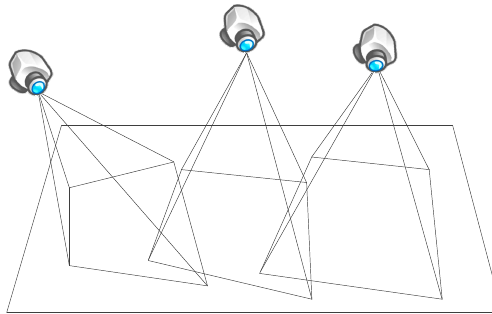
Figure 3. Cameras Network with partially overlapping coverage areas.